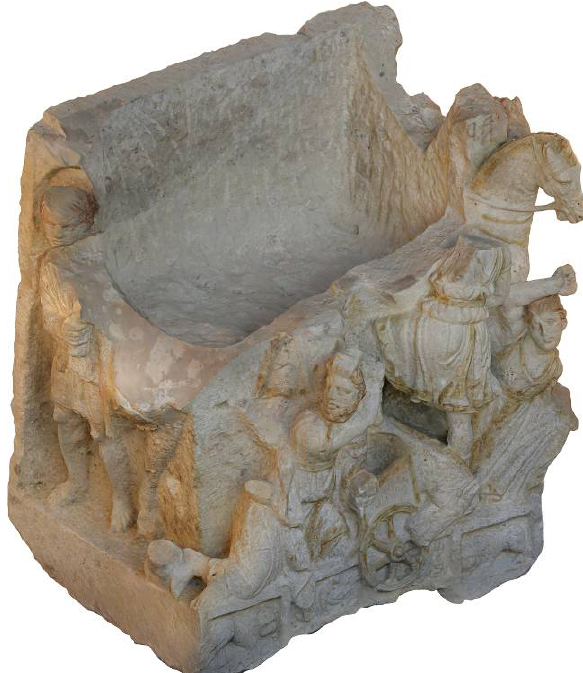
Figure 1: Orthophoto in isometric view (parallel projection), made by PhotoScan. the 3D model is mapped directly from the photos with textures of 16,000 pixels per side. Two of the three sculpted sides are